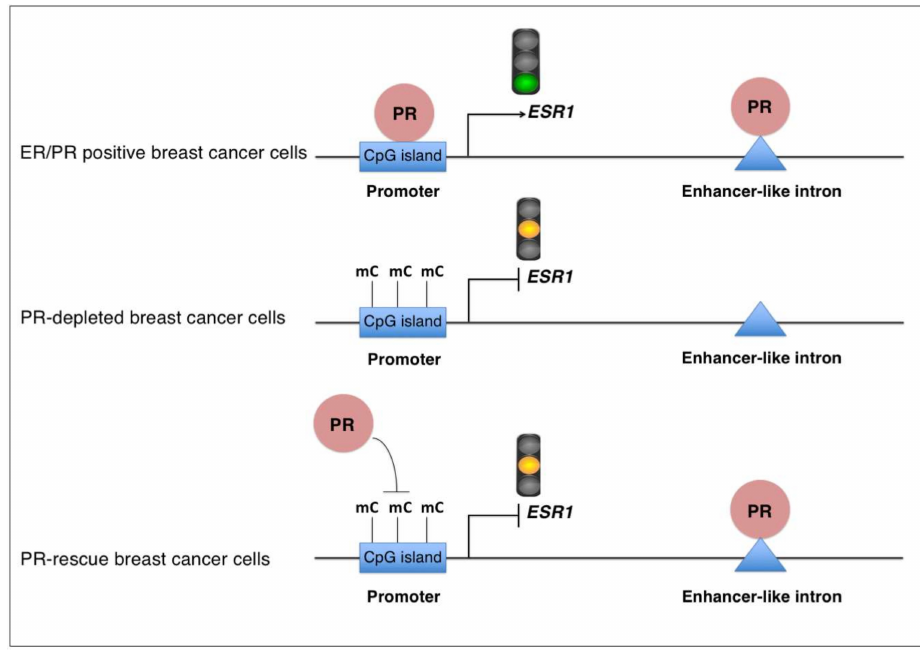
Figure 7. Model of the regulation of the ESR1 gene expression and DNA methylation by PR in hormone-free breast cancer cells. In hormone-free ER+/PR+ breast cancer cells, PR binds to the low-methylated gene promoter, as well as to an enhancer-like intronic sequence of ESR1 . PR binding at the gene promoter is required for maintaining ESR1 transcription. In the absence of PR, DNA methylation (mC) increases at the ESR1 promoter, and ESR1 transcription is reduced. Re-expression of PR in PR-depleted cells leads to PR binding to the low-methylated enhancer-like intronic sequence, but the high level of DNA methylation (mC) at the ESR1 promoter impedes PR binding to this genomic region. Consequently, re-expression of PR in PR-depleted cells is insufficient to restore ESR1